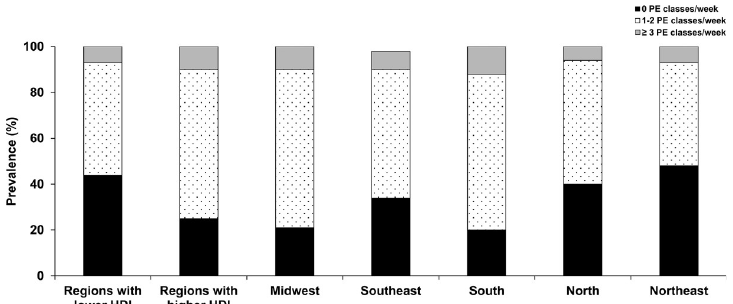
Fig 2. Distribution of participation frequency in physical education classes per week by study region (n = 12,220). HDI: Human Development Index; PE: physical education.